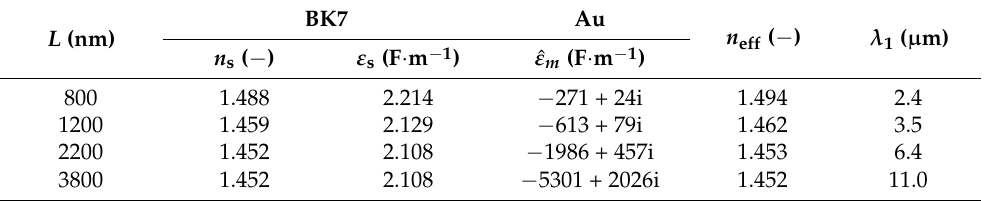
Table 1. Calculation of wavelength values for basic dipole modes of the complementary scatterers.